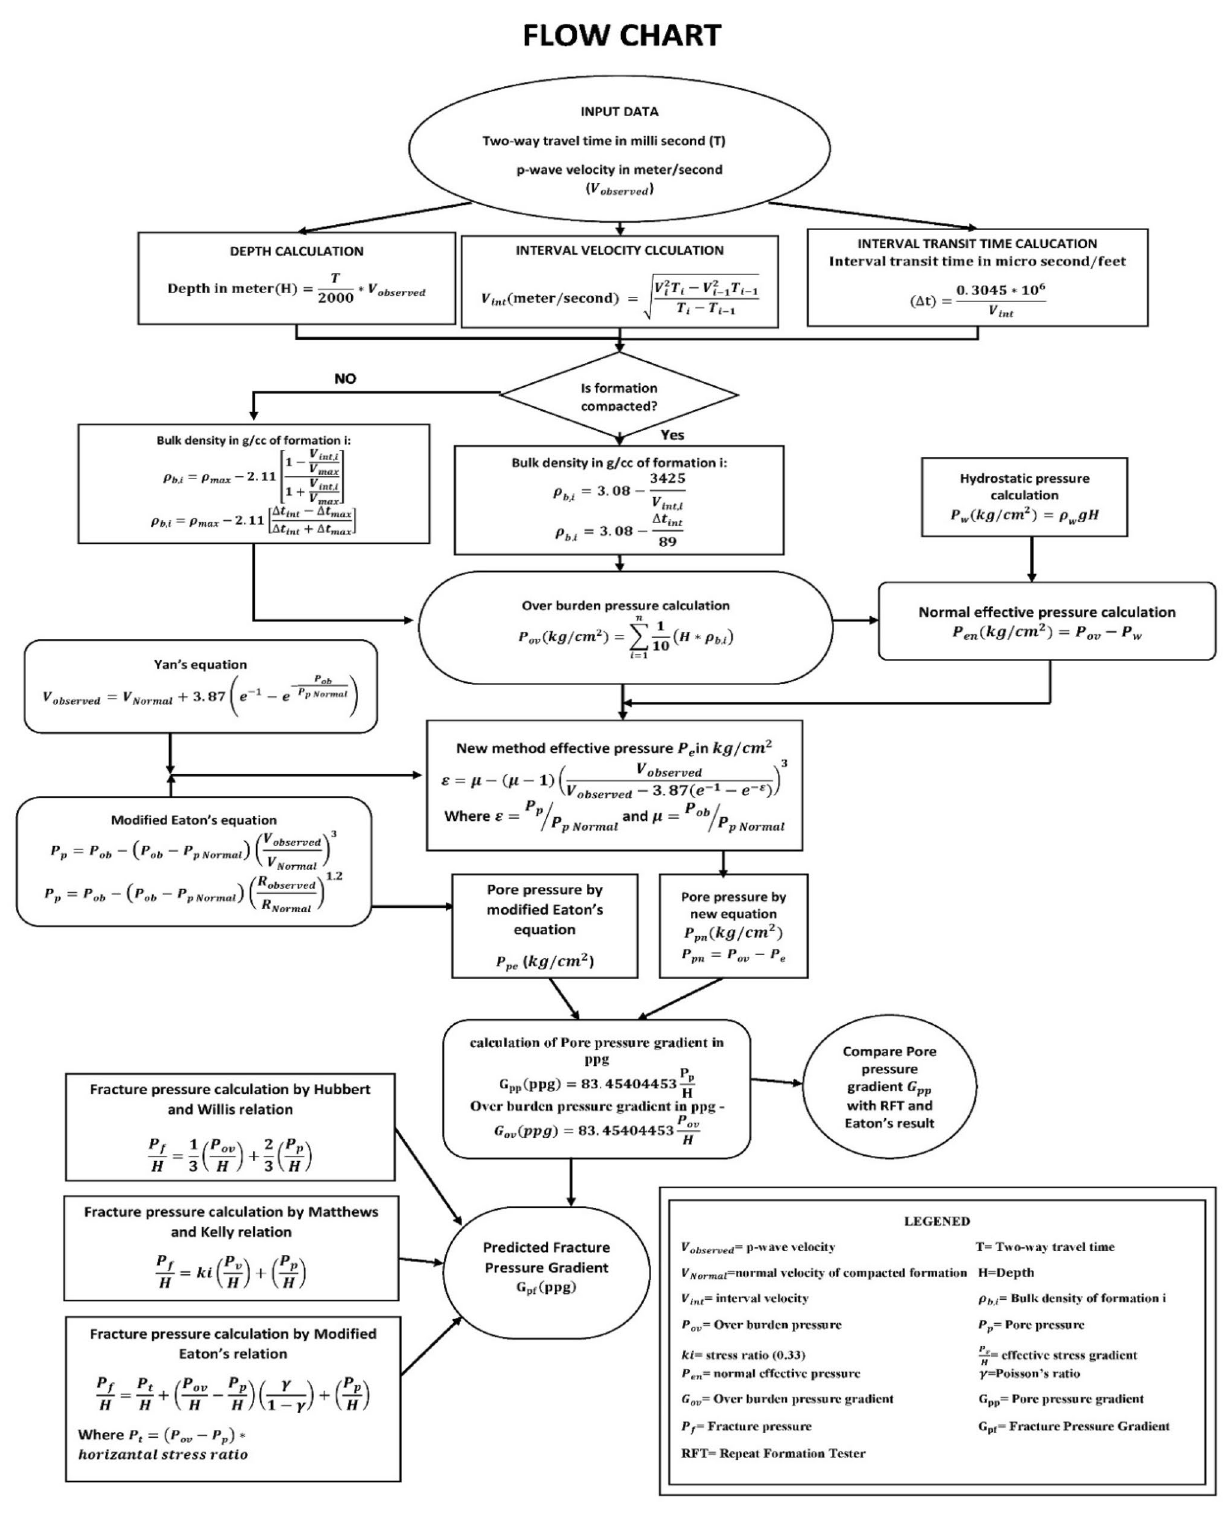
Fig. 4 Pore pressure prediction and fracture pressure